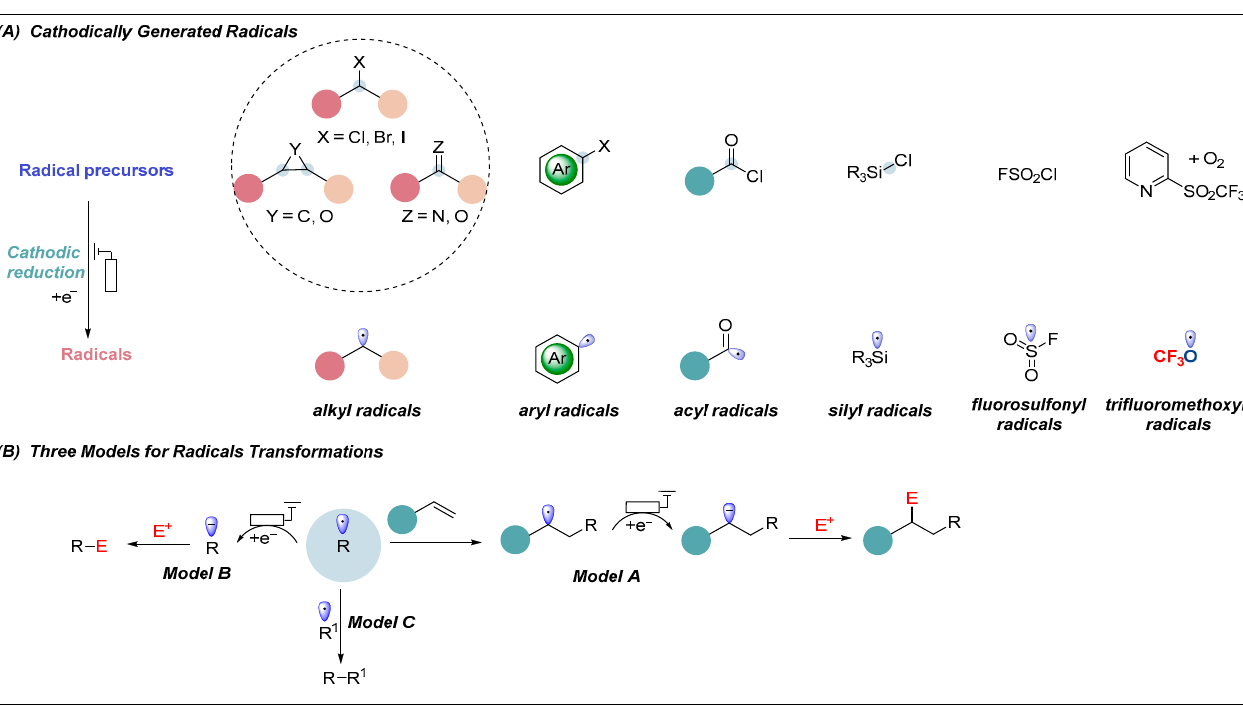
Figure 1. Cathodically generated radicals and the general mechanism of electroreductive transformations.